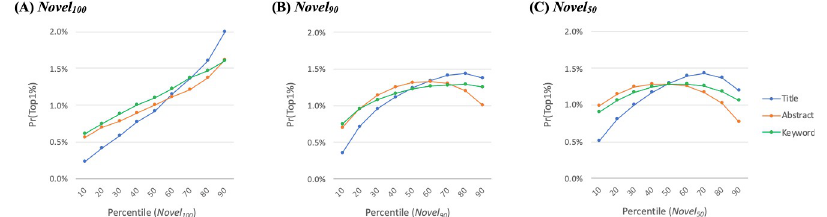
Fig 4. Prediction of top-1% citation rank. The probability of a focal document falling within the top 1 percentile is predicted. For easier interpretation and comparison, the horizontal axis takes the percentile of the novelty measures. (A) based on Row 1 in Table 5. (B) and (C) based on curvilinear models incorporating the quadratic term of the novelty measures (S1 Appendix).